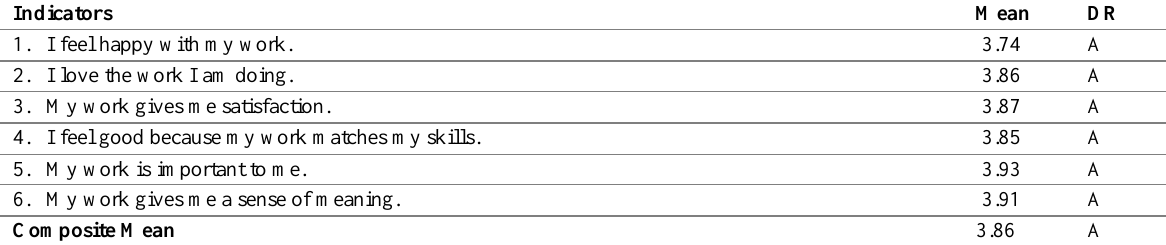
Table 2: The Attitude of Employees toward their work in terms of Affective Attitude Indicators